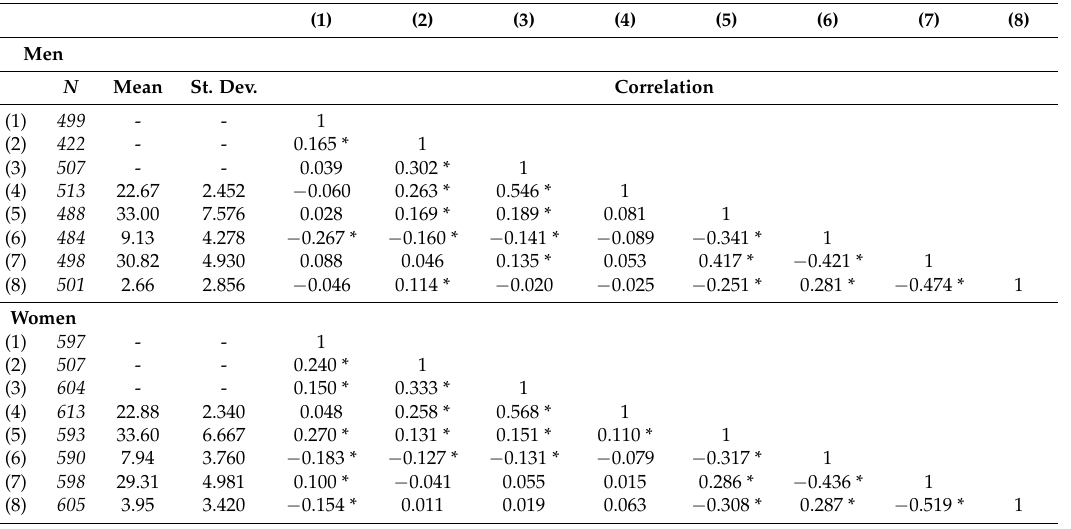
Table 2. Descriptive statistics between dependent and independent variables ( N , mean, Standard Deviation and Correlations).